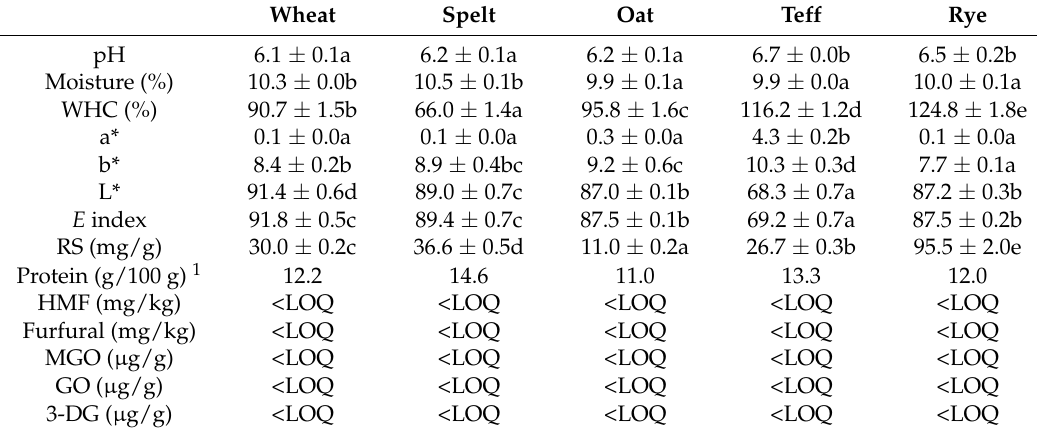
Table 1. Characterization of flours in terms of pH value, moisture, water holding capacity, L*a*b* colour scale, colour E index, reducing sugars content, protein, hydroxymethylfurfural, furfural, methylglyoxal, glyoxal, and 3-deoxyglucosone.